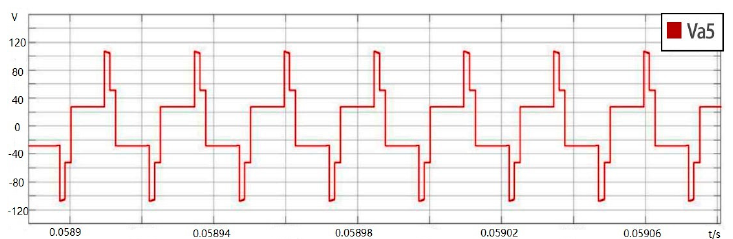
Figure 14. Inductance voltage waveforms.